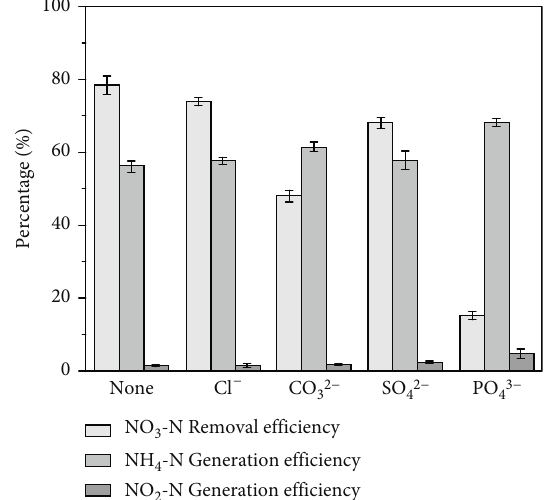
Figure 8: Rates of NO -N removal and ammonia nitrogen and nitrite 3 generation in presence of coexisting ions (anion concentration to nitrate nitrogen ion ratio = 4 : 1 , mass ratio of ATP-nZVI material = 1 : 1 , initial NO -N removal rate -N concentration = 30 mg/L, adsorbent = 1 : 5 g/L, pH 3 3 = 7 , reaction temperature = 25 ° C, and contact time = 150